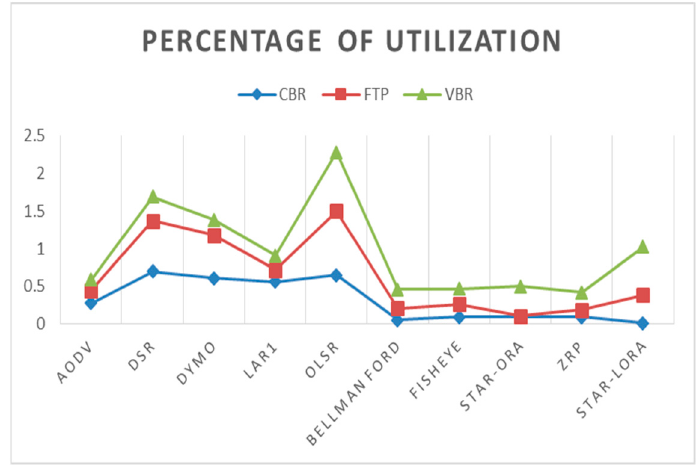
Figure 18. Percentage of utilization of all routing protocols for 60 nodes.